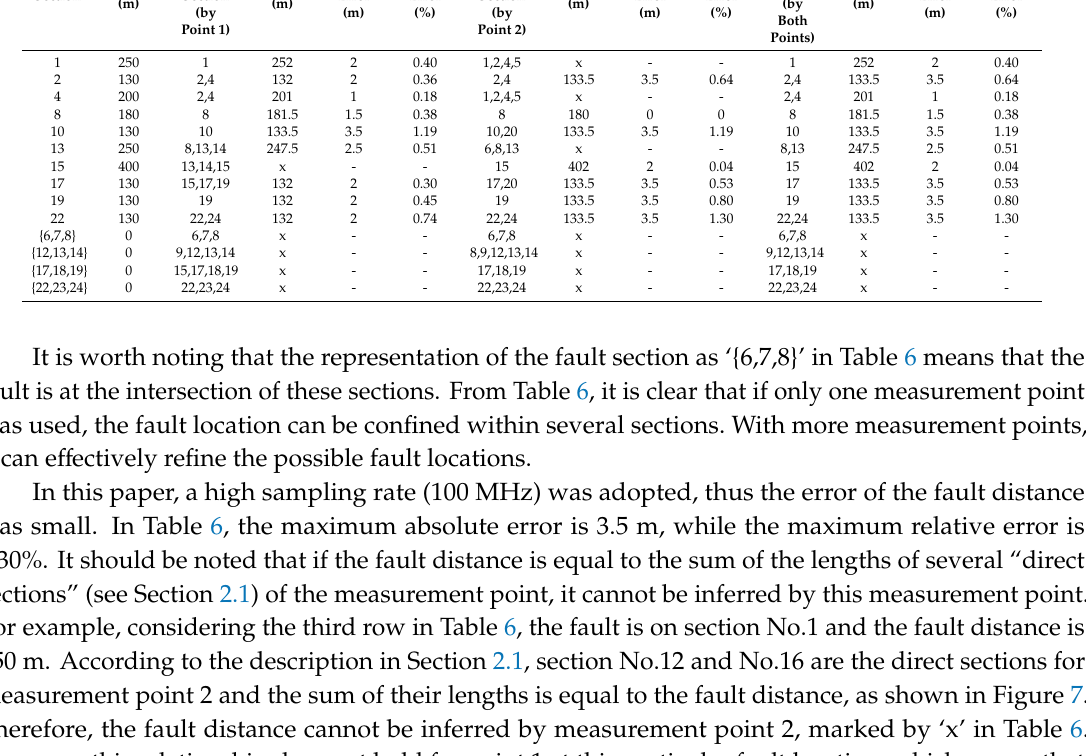
Table 7. Simulation results under different transition resistances. Fault Setting